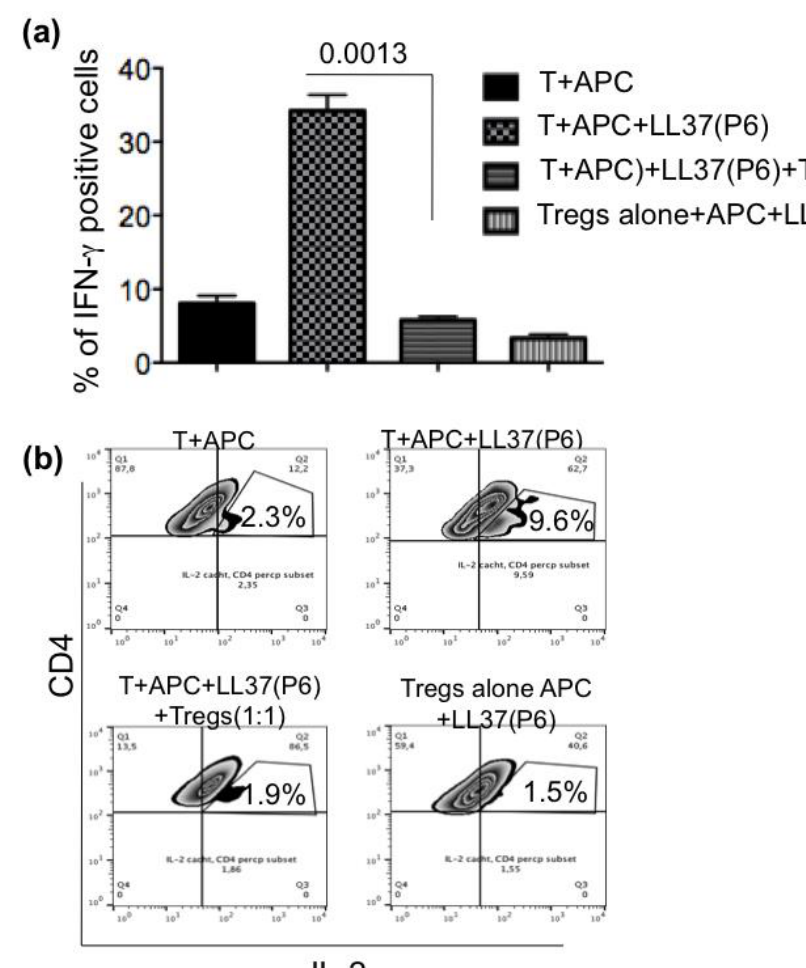
Figure 2. Tregs LL37-specific can be present in HD and be suppressive in vitro. ( a ) T-cell clone (T), derived from a HD and specific for LL37 (peptide P6), was cultured either alone, or with APC alone or APC presenting its cognate antigen LL37 P6, or in the presence of Tregs isolated and enriched from PBMC of the same HD (and pretreated with CSFE) (as in Figure S1), also in the presence of APC and antigen (P6), overnight. Tregs were also cultured, alone, with APC and antigen P6. APC were irradiated to block their proliferation. The day after cells were harvested and IFN- γ production was assed, by intracellular staining and flow cytometry in gated T-cells derived from clone T (which were CSFE negative and distinct from the CSFE + Tregs) as described in Methods. Experiments were repeated two times (in duplicates), with the same donor. ( b ) The same type of experiment was performed with clone T in the culture conditions of ( a ), but for 2 hours, detecting IL-2 production by the clone T by catch assay (see methods).